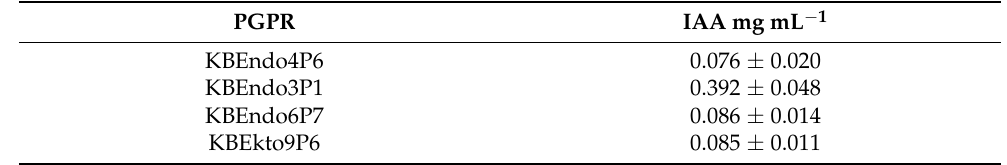
Table 2. Evaluation of the production of indole acetic acid IAA by the different rhizobacteria.